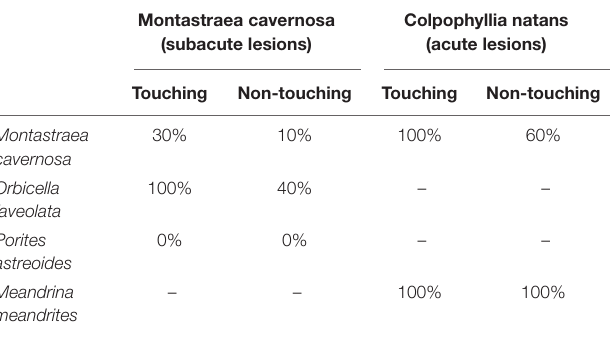
TABLE 2 | Summary of results for aquaria studies examining the transmission of Montastraea cavernosa with subacute lesions and Colpophyllia natans with acute lesions to different test species.